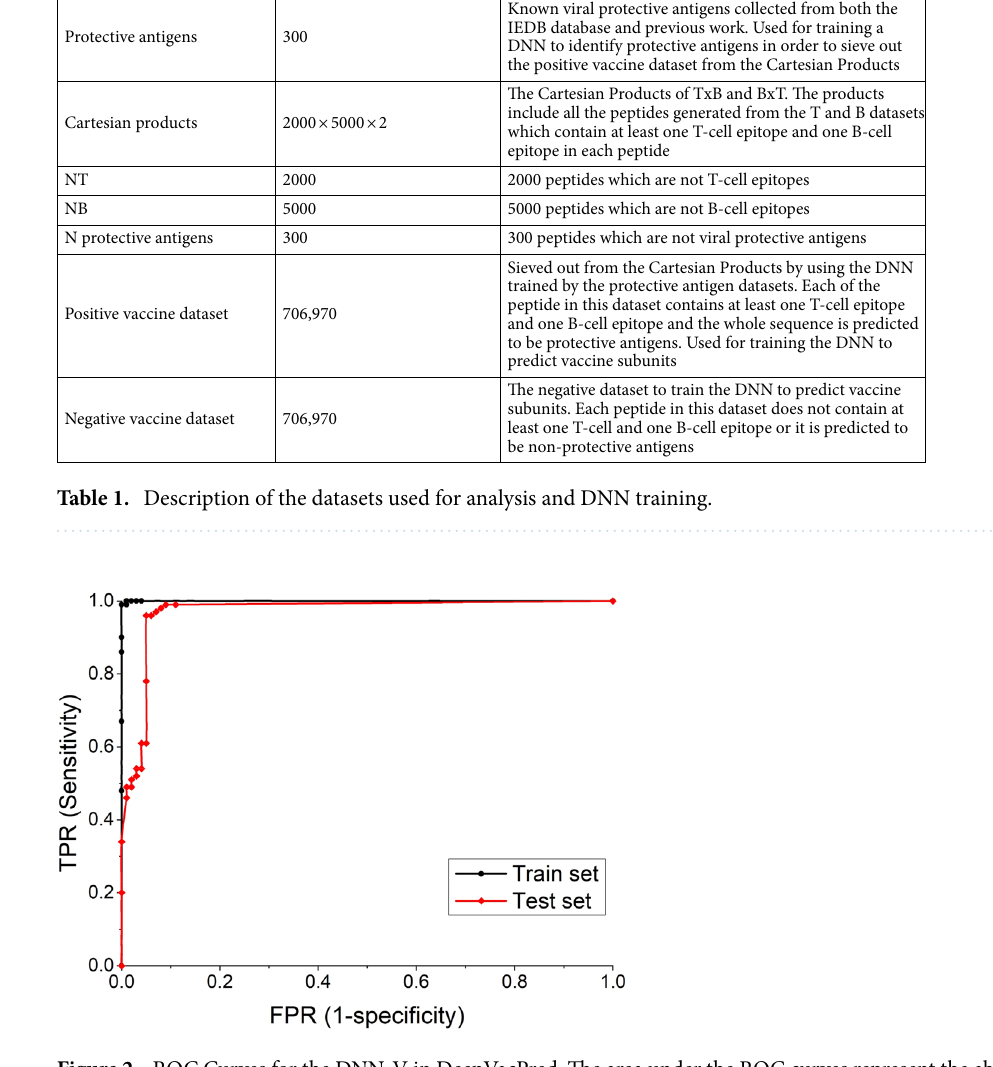
Figure 2. ROC Curves for the DNN-V in DeepVacPred. The area under the ROC curves represent the ability of the DNN-V to classify potential vaccine subunits and non-potential vaccine subunits. The high area under the ROC curves suggests that the DNN-V has strong classification ability and high accuracy at most threshold